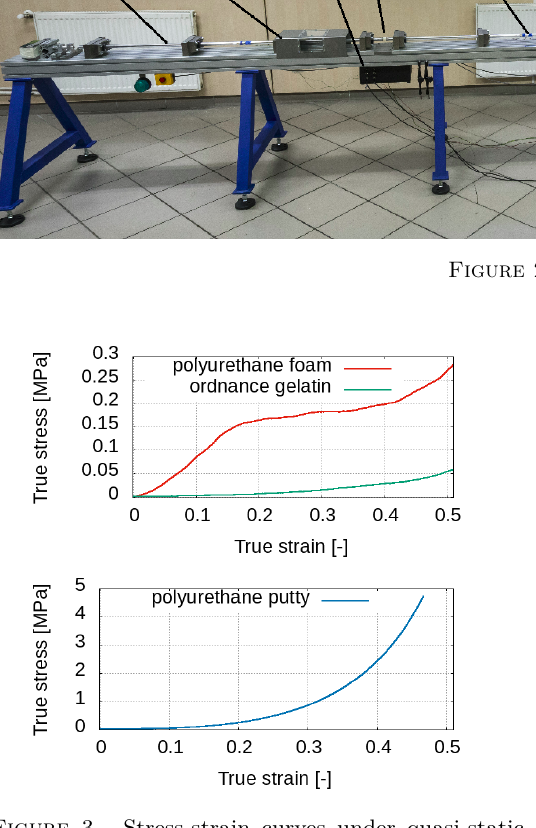
Figure 3. Stress-strain curves under quasi-static compression.